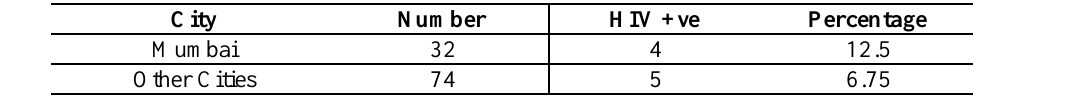
Table II : Migrants destination within India